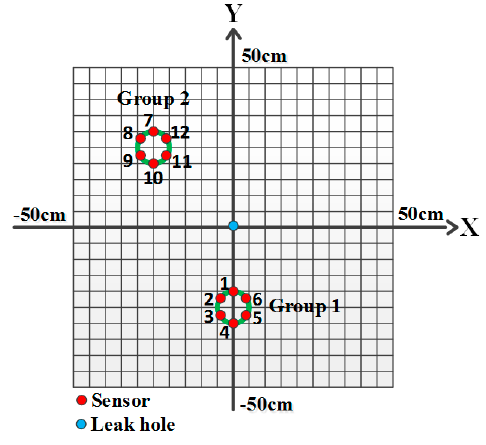
Figure 9. An optimized array arrangement.